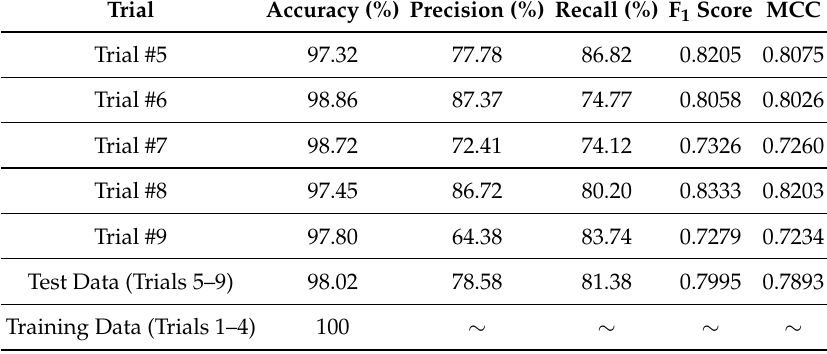
Table 8. Performance of stationarity